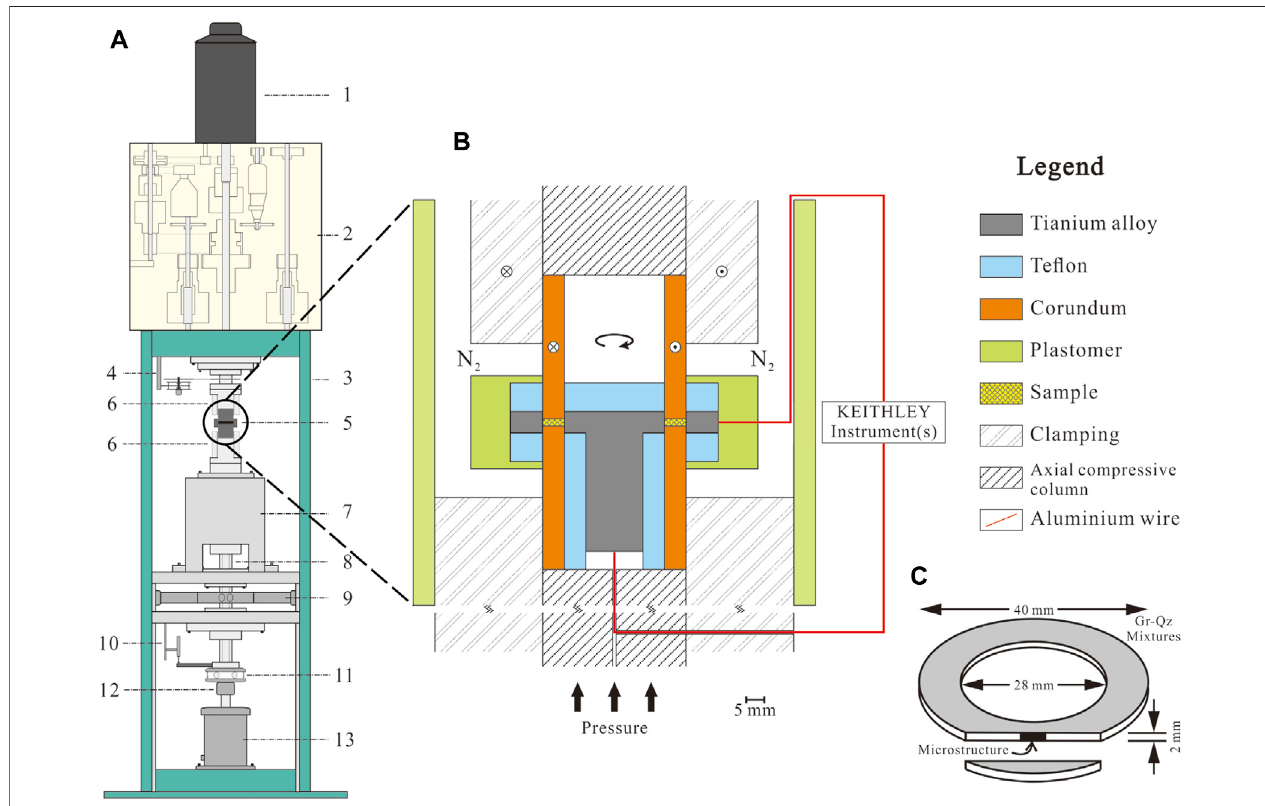
FIGURE 2 | (A) Schematic diagram of a rotary shear low to high-velocity friction apparatus used in the experiments: 1-servo-motor, 2-gear/belt system for speed changes, 3-loading frame, 4-rotary encoder, 5-specimen assembly, 6-locking devices for specimens, 7-frame for holding the lower loading column, 8-axial loading column, 9-torque gage, 10-axial displacement transducer, 11-thrust bearing, 12-axial force gage, 13-air actuator (for details, see Ma et al., 2014). (B) Inner structure of the gouge specimen assembly is adapted for transient electrical conductivity measurements by a two- or four-wire setup. The half arrows indicate the shear direction. (C) Geometry of the specimen layer and the location of the BSE